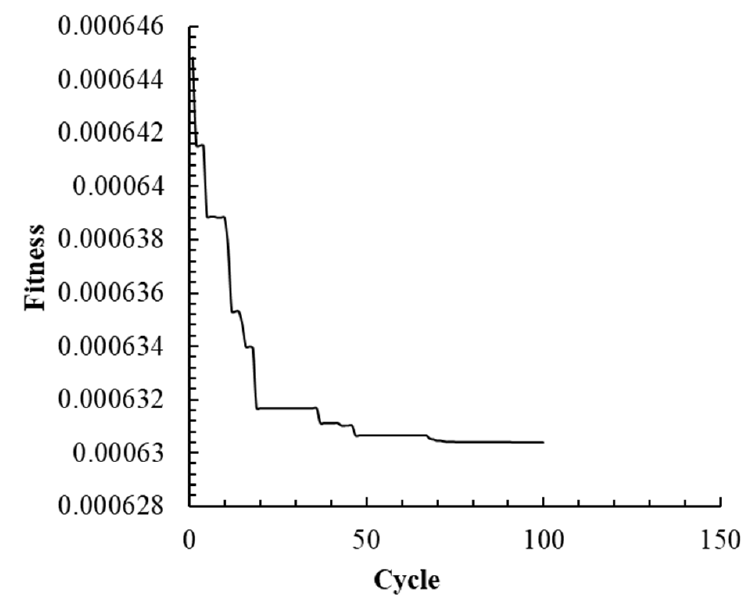
Figure 19. The convergence of ABC algorithm.